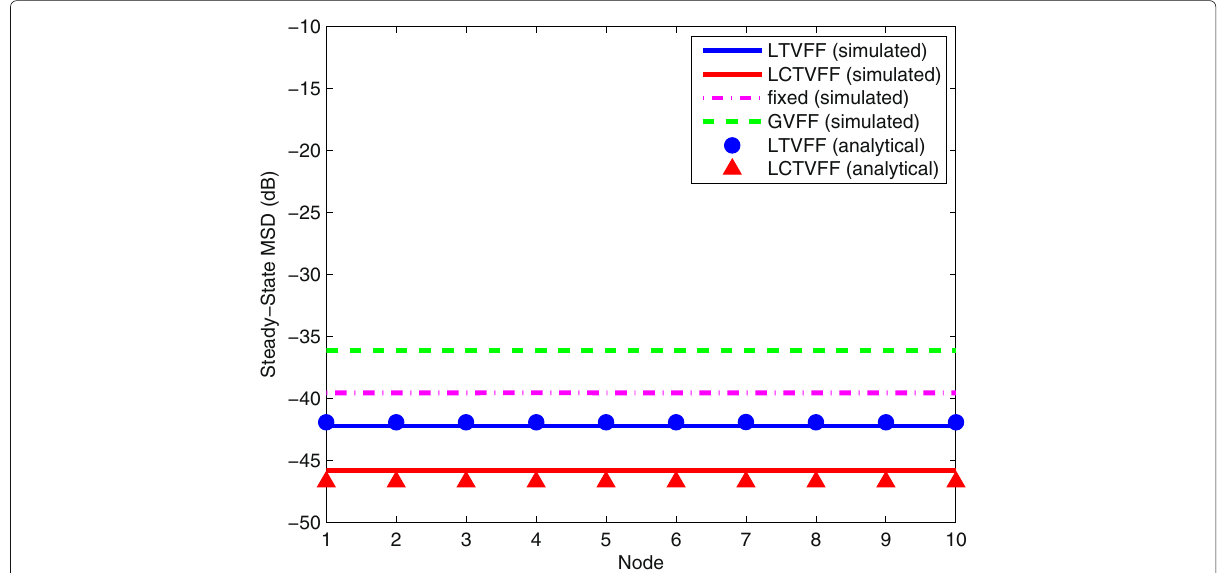
Fig. 12 Steady-state MSD value versus node for the proposed and existing